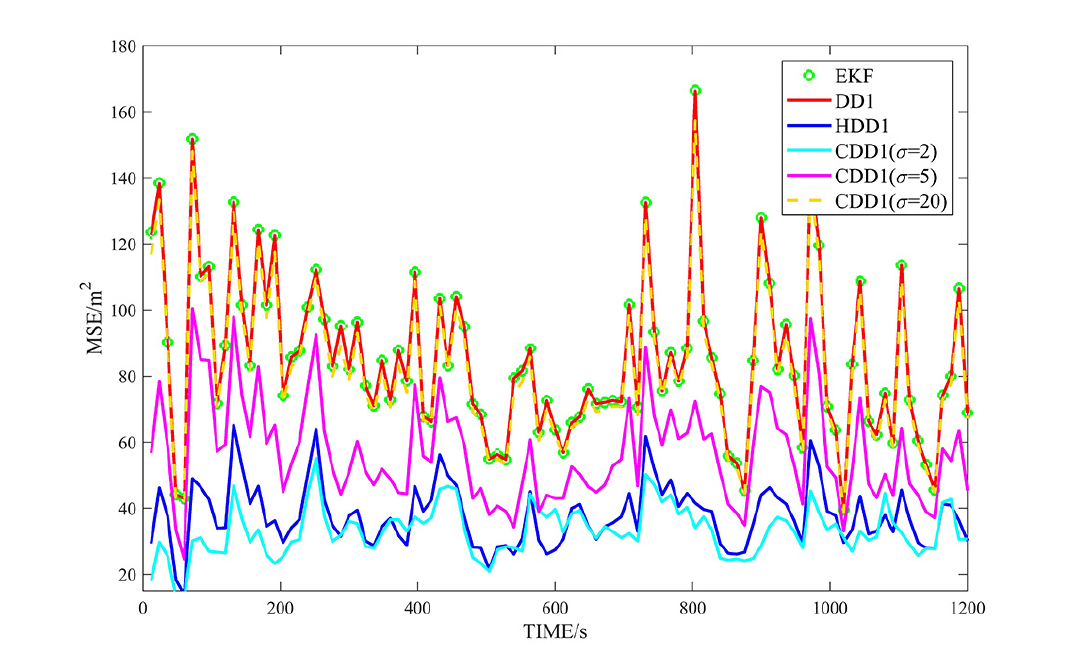
Figure 3. MSEs of λ with first-order approximate filters in non-Gaussian